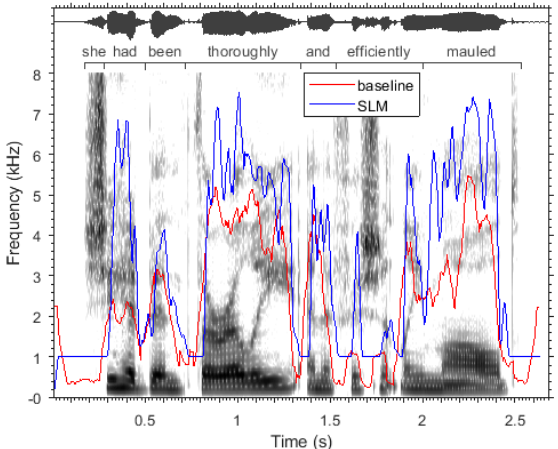
Figure 6. Importance of the SLM in MVF estimation. Top is the speech waveform from a female speaker, bottom is the spectrogram and MVF contours.